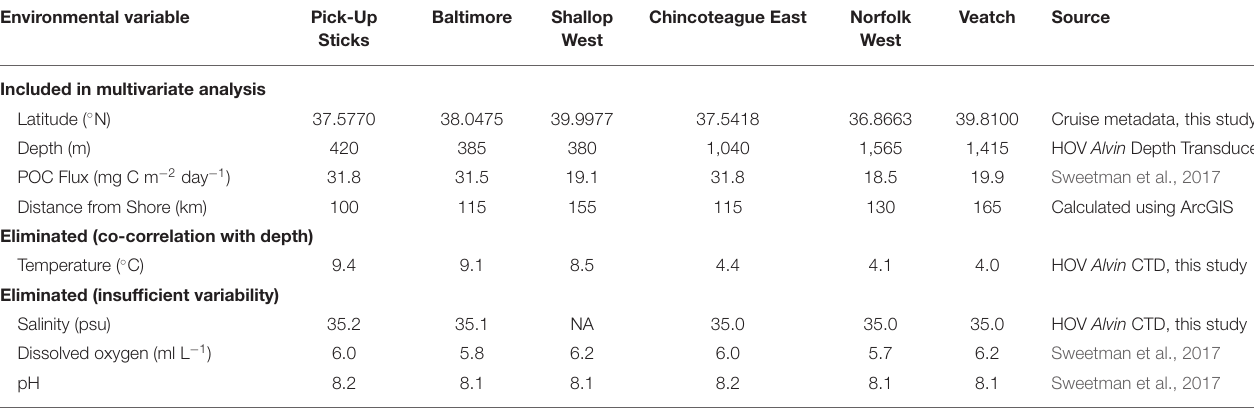
TABLE 3 | Environmental variables considered in the BEST multivariate analysis. Environmental